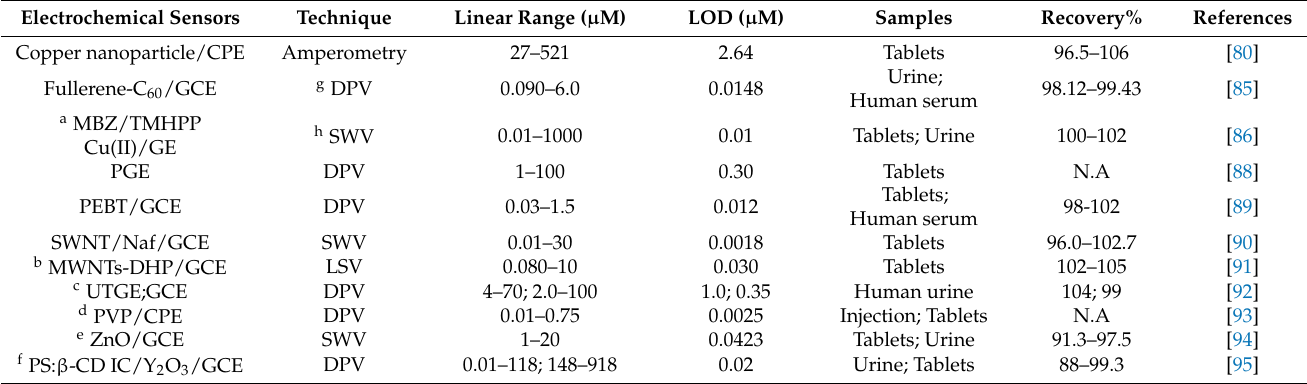
Table 9. Various electrochemical sensors for the detection of ACV (“N.A”: No data applicable or available). Electrochemical Sensors